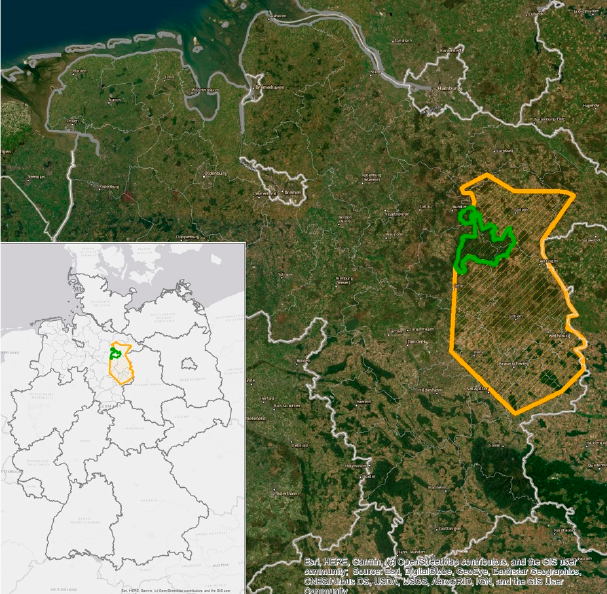
Figure 1. Map of Germany ( left ), indicating the site of the study area in Lower Saxony, Germany ( right part of the figure), showing forestal–agricultural habitat (fah, outlined in orange) around the large contiguous forestal habitat (fh, outlined in green) where wild boar females of this study were sampled.